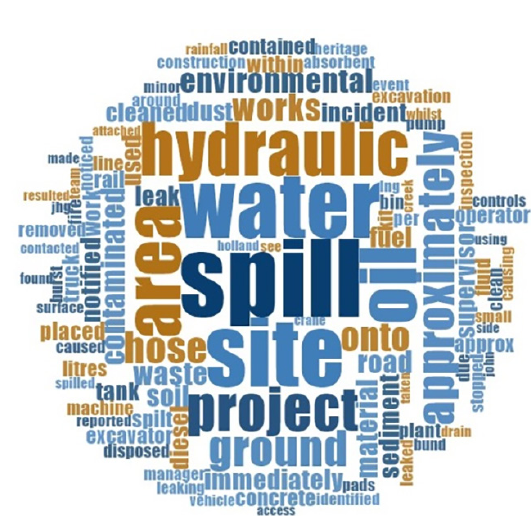
Figure 2. Word cloud analyses of causes of incidents